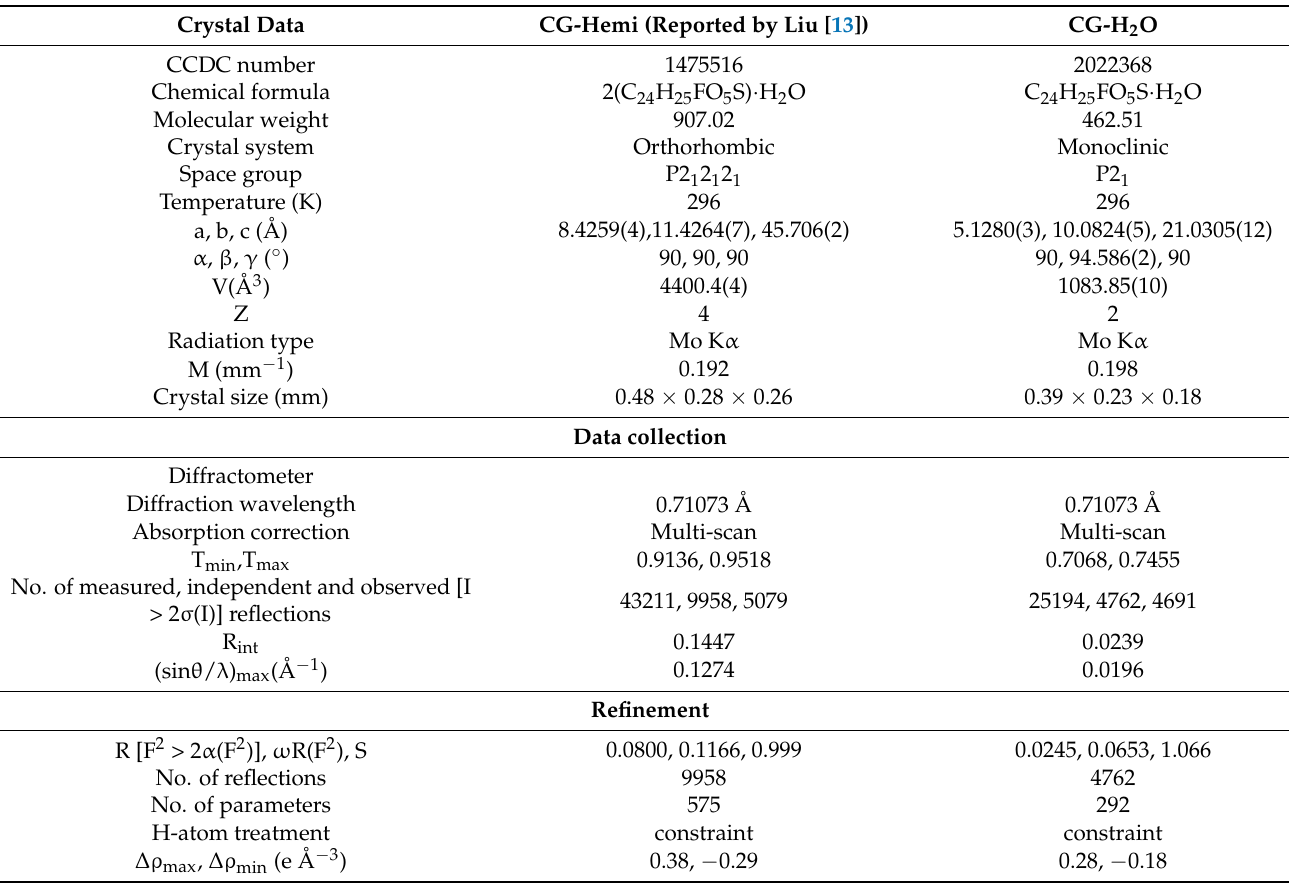
Table 1. Crystal parameter data of CG-Hemi and CG-H 2 O.